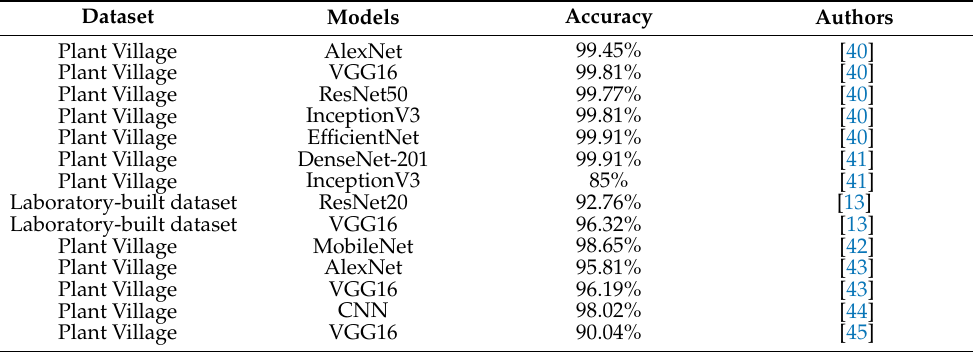
Figure 10. Factors influencing plant disease prediction classified as extrinsic and intrinsic factors. Table 8. Comparison of several CNN architectures in terms of performance